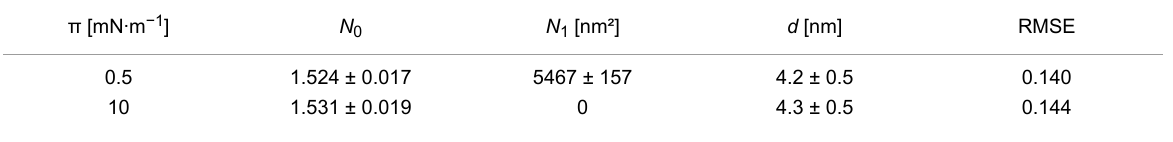
Table 1: Film thickness, d , and Cauchy coefficients of the refractive index, n ( λ ), derived from VASE measurements of PPDL-D4 Langmuir layers where RMSE is the root mean square